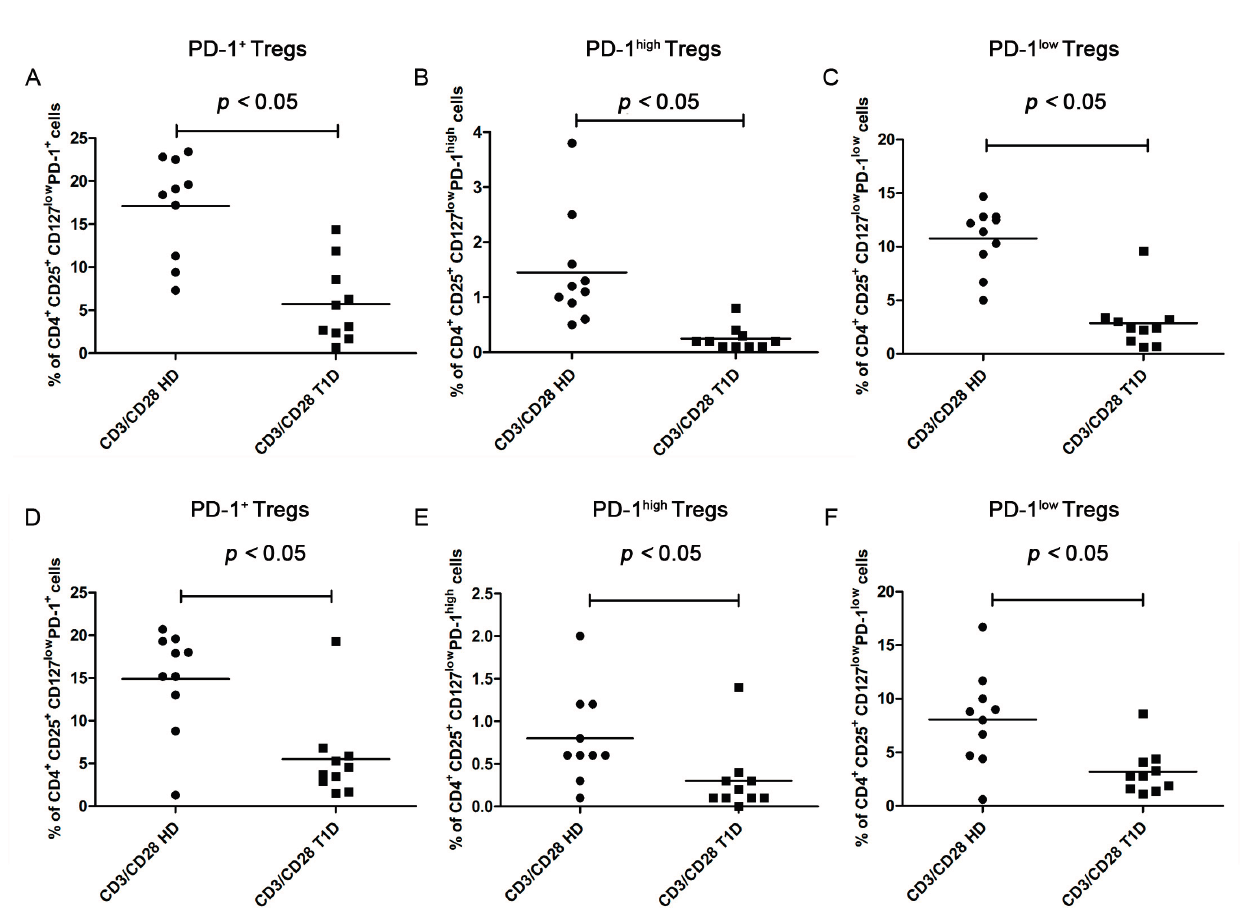
Figure 3. Percentages of PD-1 + Tregs after CD3/CD28 stimulation in healthy controls